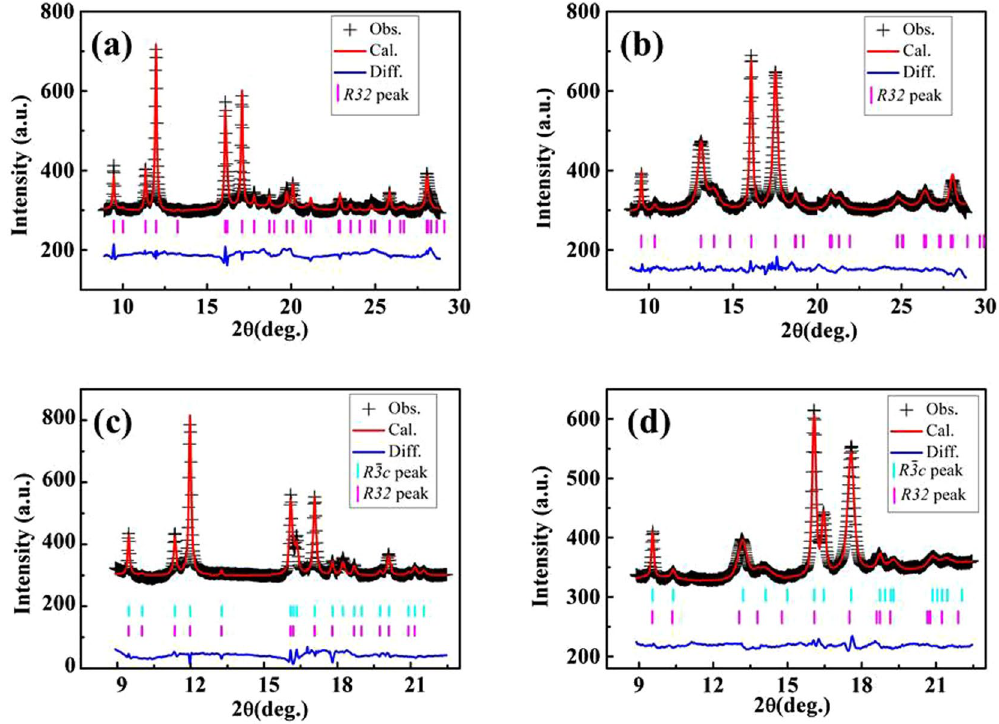
Figure 1. Synchrotron PXRD patterns for flux-KBBF at ambient pressure ( a ) and 9.7 GPa ( b ), and hydro-KBBF at ambient pressure ( c ) and 10.2 GPa ( d ). Plus ( + ) symbols: the observed patterns; Red lines: the refined patterns; Blue lines: the difference between observed and refined patterns; Magenta and cyan vertical ticks indicate the calculated position of Bragg reflections for R32 and R c 3 structures, respectively. A sloping background has been removed from all the experimental diffraction